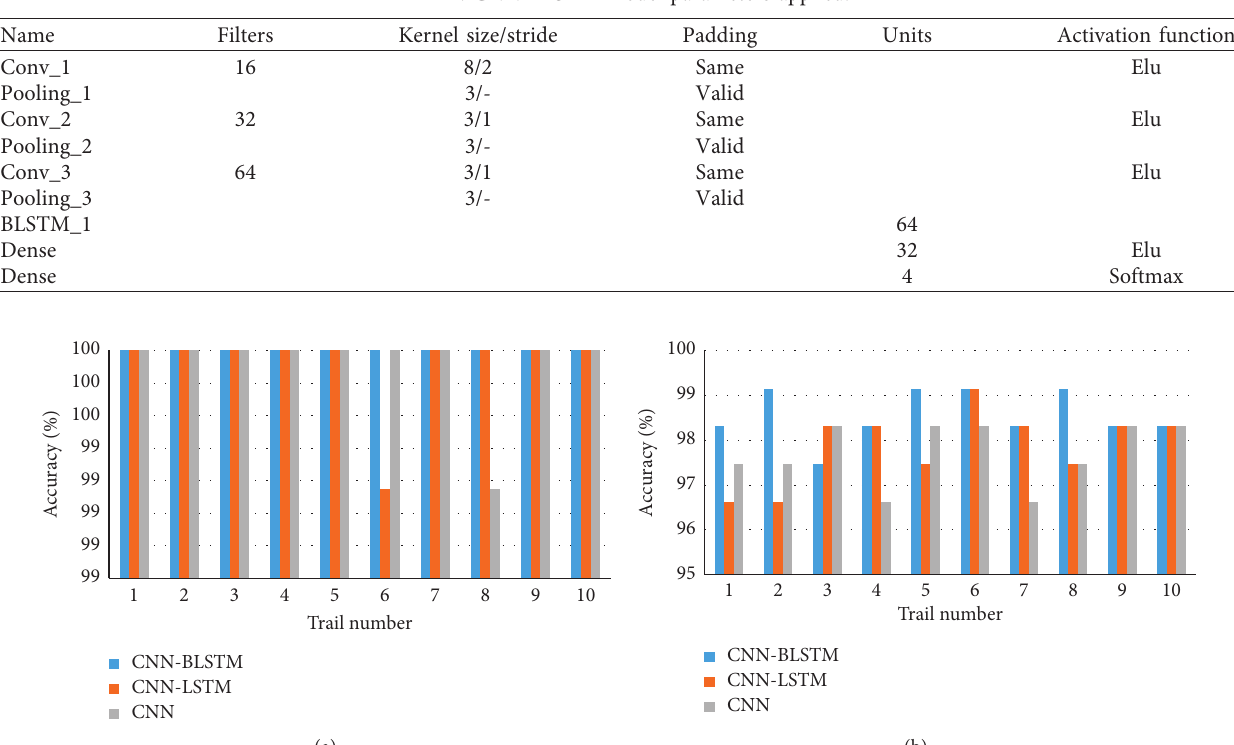
Table 2: CNN-BLSTM model parameters applied.